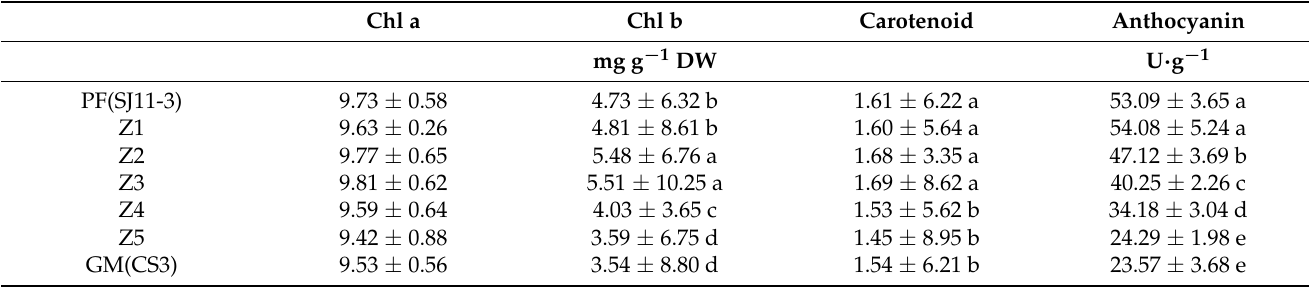
Table 1. Pigment content of different purple peppers.